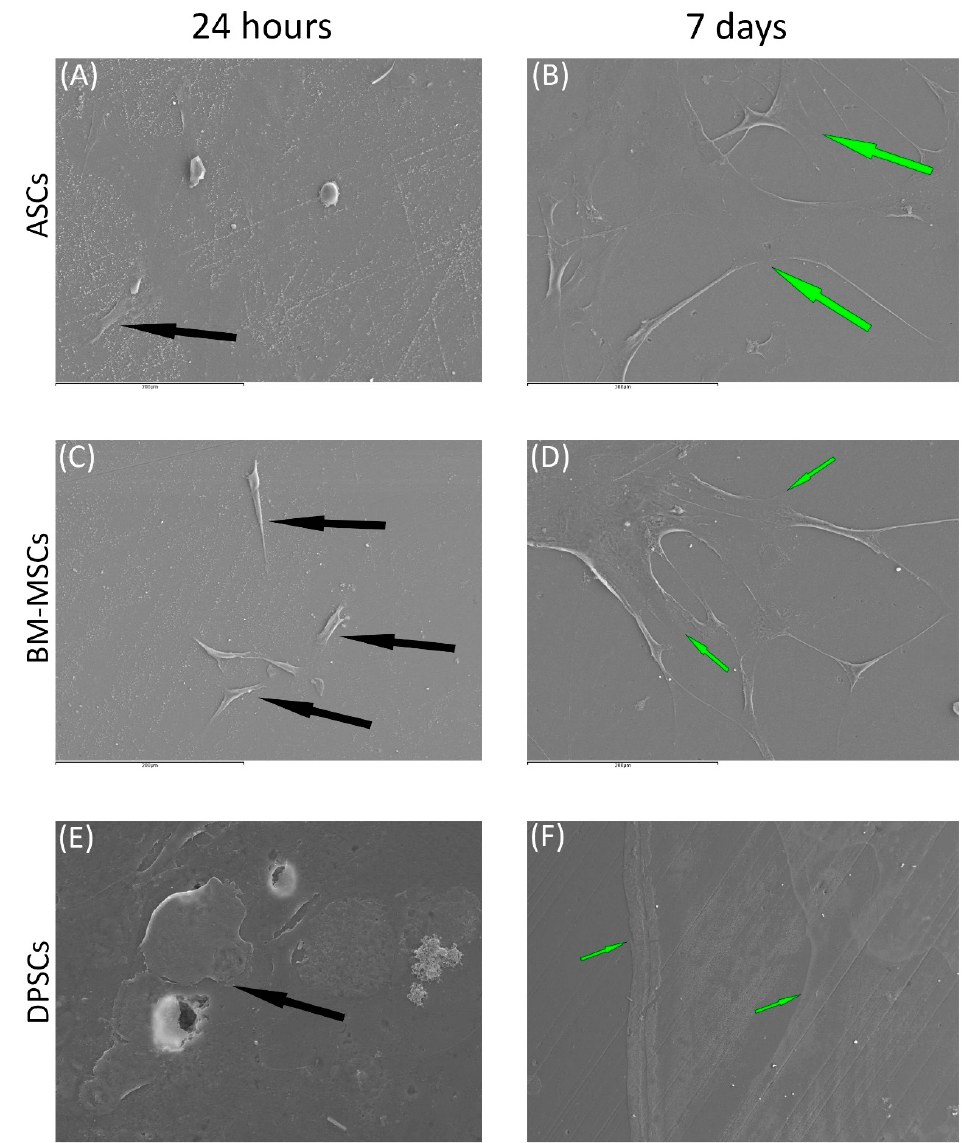
Figure 3. The behaviour of MSCs seeded on ß-TCP scaffold at different time points: ( A ) ASCs on ß-TCP scaffold after 24 h (scale bar: 200 μ m); ( B ) ASCs forming cell layer on ß-TCP scaffold after 7 days (scale bar: 200 μ m); ( C ) BM-MSCs on ß-TCP scaffold after 24 h (scale bar: 200 μ m); ( D ) BM-MSCs forming cell layer on ß-TCP scaffold after 7 days (scale bar: 200 μ m); ( E ) DPSCs on ß-TCP scaffold at 24 h (scale bar: 50 μ m); and ( F ) DPSCs forming cell layer on ß-TCP scaffold after 7 days (scale bar: 200 μ m). Black arrows indicate unique cells. Green arrows indicate cell layers.